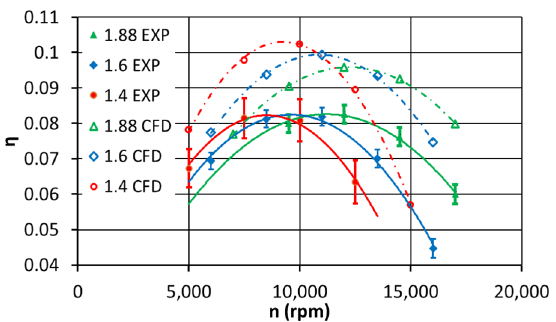
Figure 13. Efficiency as a function of rotational speed for CFD and experiment.